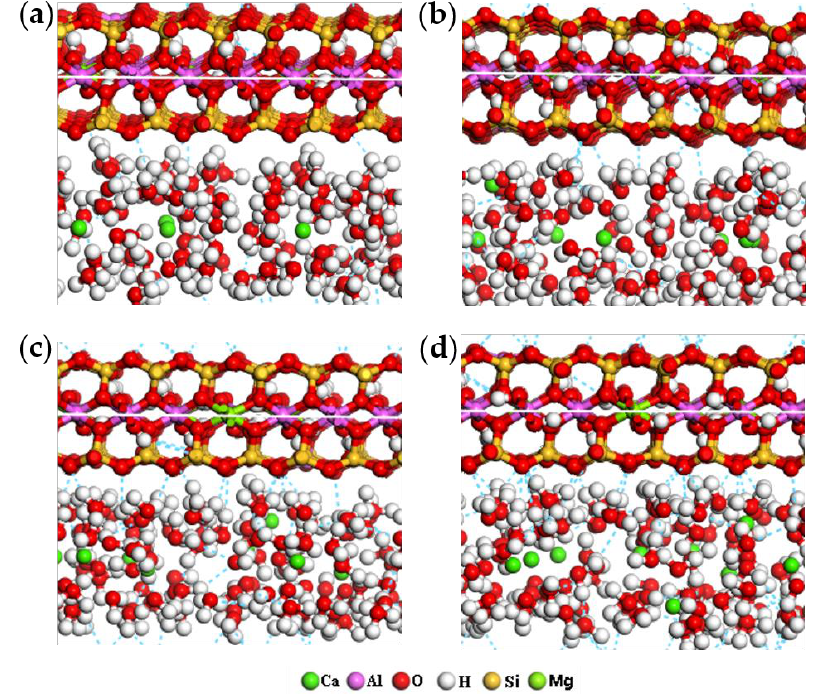
Figure 9. Schematic diagram of hydrogen bond of montmorillonites with different layer charge density (dashed line is hydrogen bond). ( a ) 0.375; ( b ) 0.500; ( c ) 0.563; ( d ) 0.688. Table 4. The hydrogen bond number and adsorption energy of montmorillonites with different layer charge density.